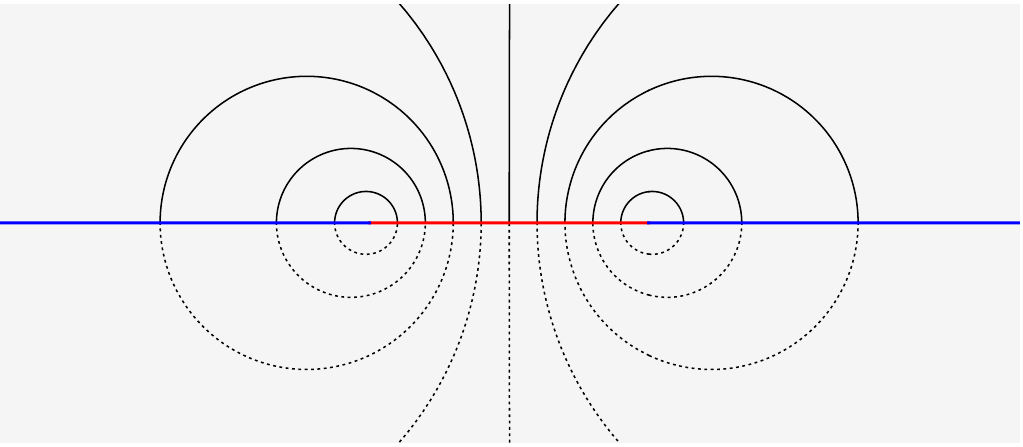
Figure 2 . Euclidean modular evolution in the complex plane: the curves are half circles obtained from (3.16) (or (3.17) equivalently) with θ ∈ (0 , π ) (solid arcs) or θ ∈ ( π, 2 π ) (dotted arcs), for some x ∈ A . They map a point in A (red segment) to a point in its complement (blue half lines) and viceversa, which are related by